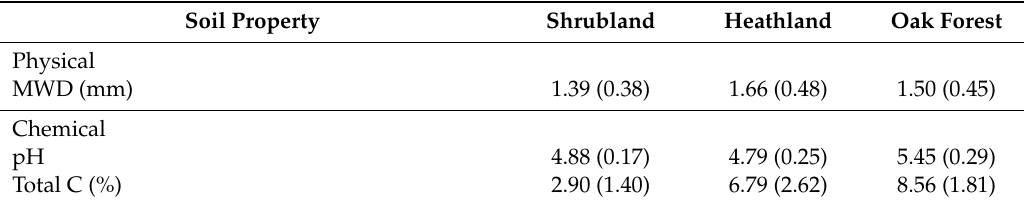
Table 2. Average values of each soil property in the control plots for each forest ecosystem